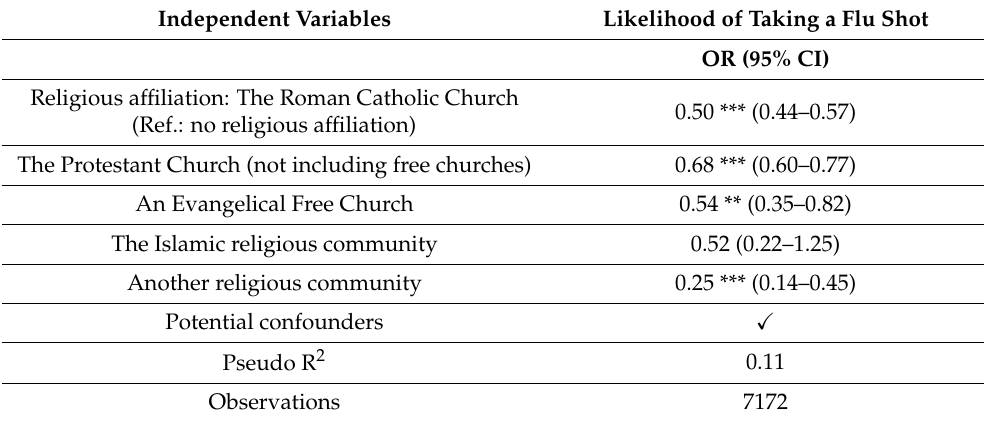
Table 2. Association between religious affiliation and likelihood of taking a flu shot (0 = no; 1 = yes). Results of multiple logistic regressions adjusted for potential confounders described in the notes. Independent Variables Likelihood of Taking a Flu Shot OR (95%